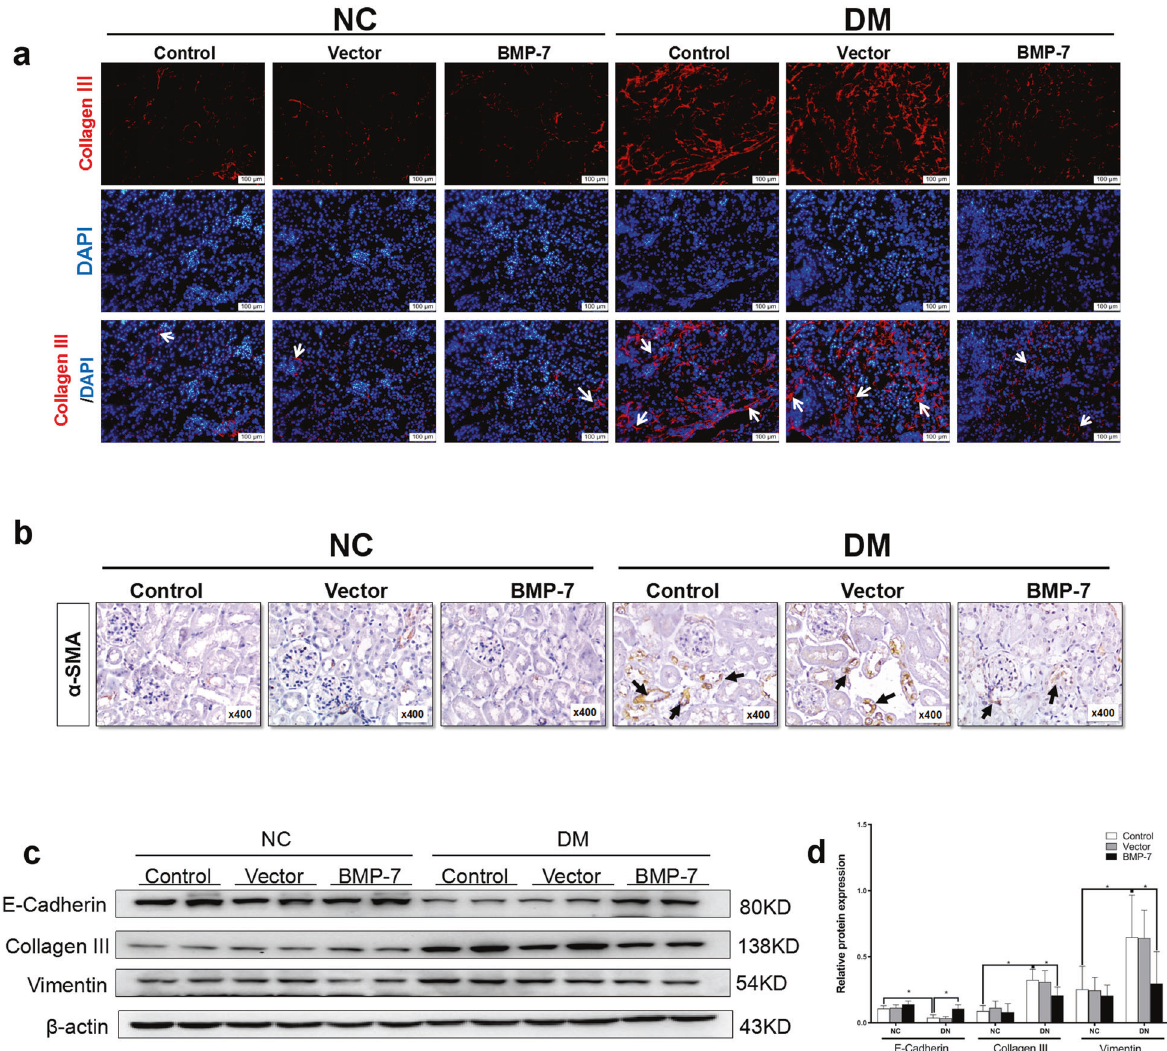
Fig. 2 BMP-7 inhibited the expression of Collagen-III and tubular epithelial to mesenchymal transition in kidneys of diabetic mice. a Representative micrographs show immuno fl uorescence staining of Collagen-III in different groups. DAPI staining(blue) represents cell nucleus, Bar = 100 um. Arrows ( → ) indicate positive expression. b Representative micrographs show immunohistochemical staining of α -SMA in different groups (magni fi cation ×400). Arrows ( → ) indicate positive expression. Representative c Western blotting and d quantitative data were revealed the expression of E-cadherin, Collagen- III, Vimentin, in the kidney tissues in different groups, * P < 0.05 ( n =